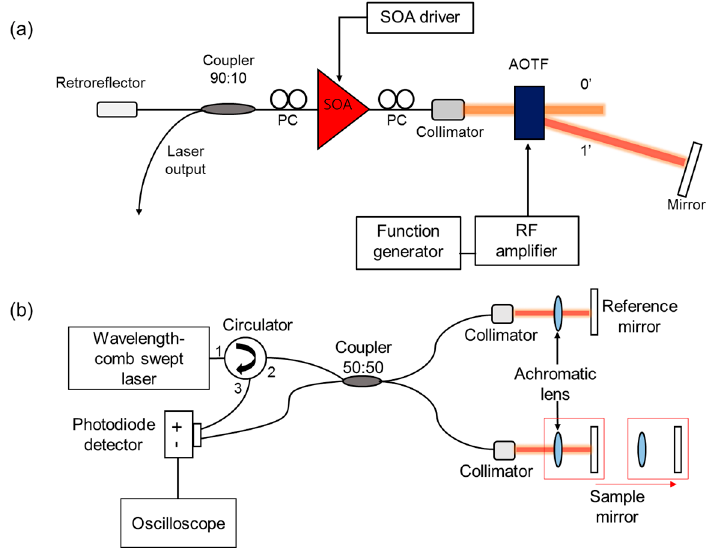
Figure 2. ( a ) Experimental setup of the WCSL with the AOTF; SOA: semiconductor optical amplifier, PC: polarization controller, AOTF: acousto-optic tunable filter; ( b ) Experimental setup for the measurement of the PSF.